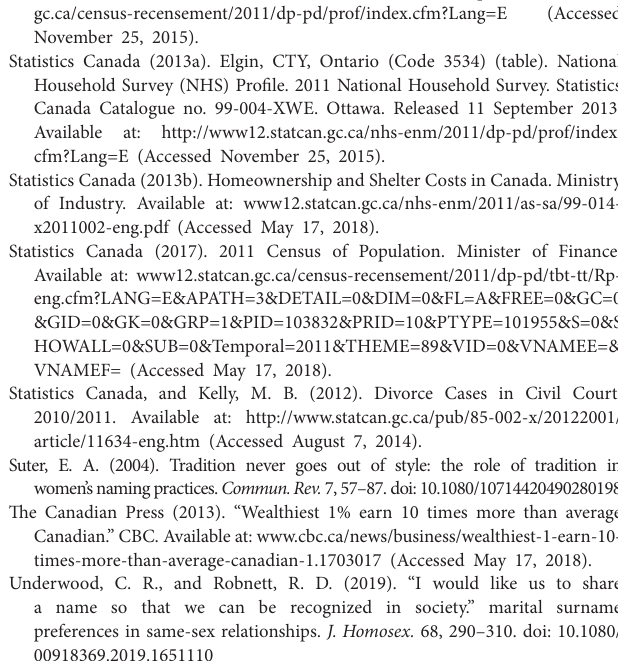
(table). Census Profile. 2011 Census. Statistics Canada Catalogue no. 98-316- XWE. Ottawa. Released 24 October 2012. Available at: